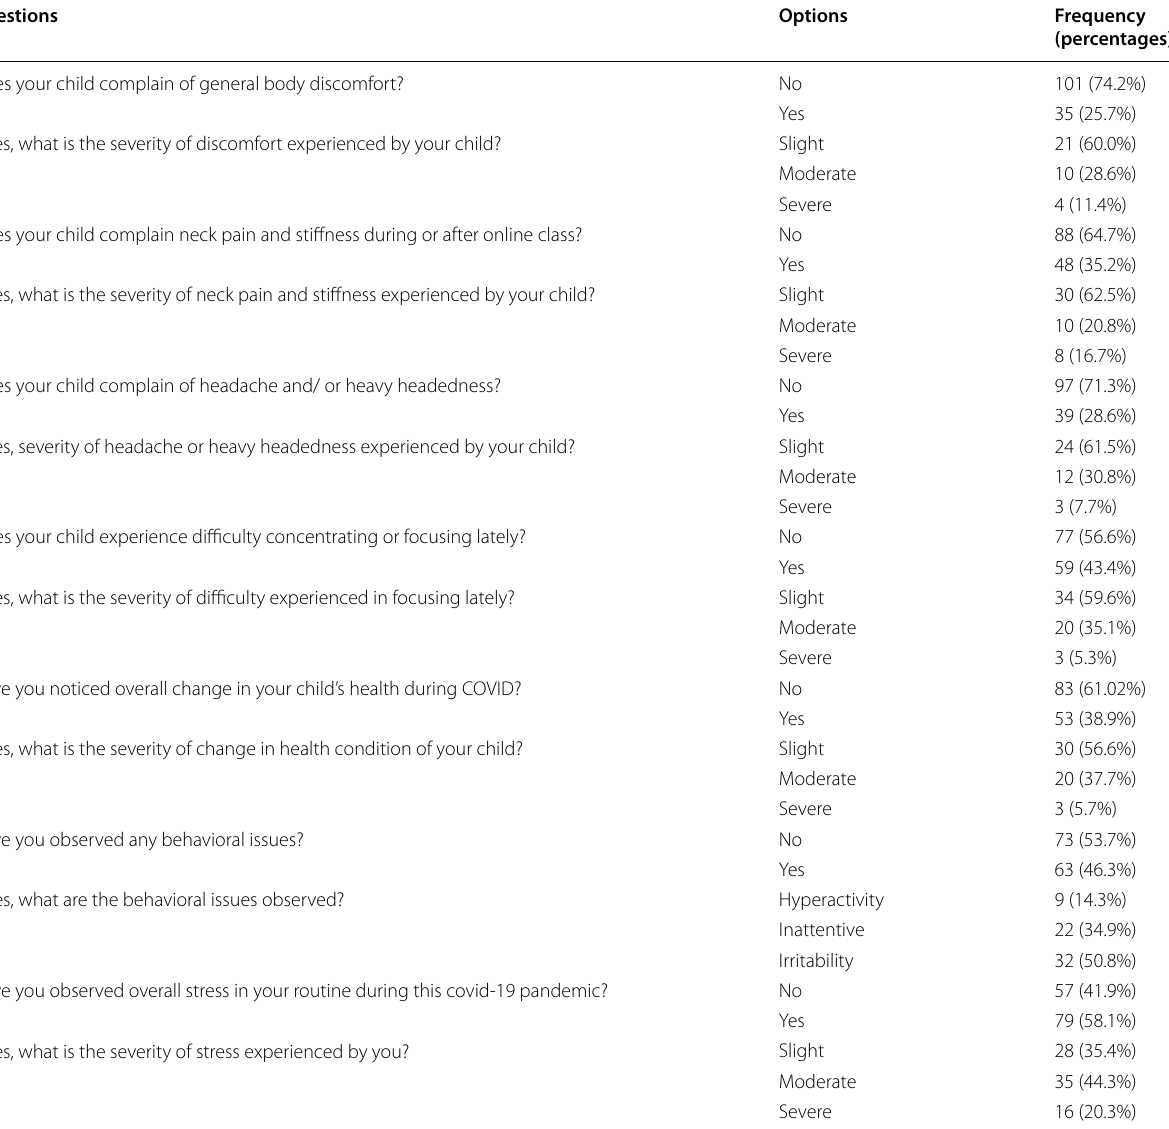
Table 6 Responses from the overall health